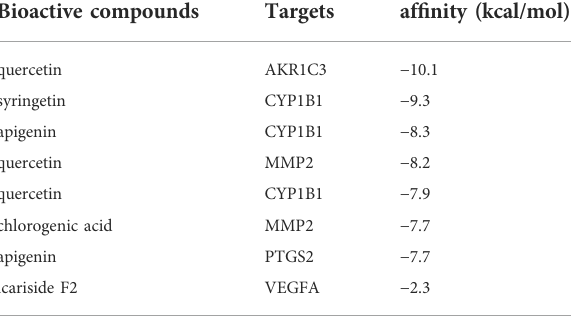
TABLE 1 Molecular docking